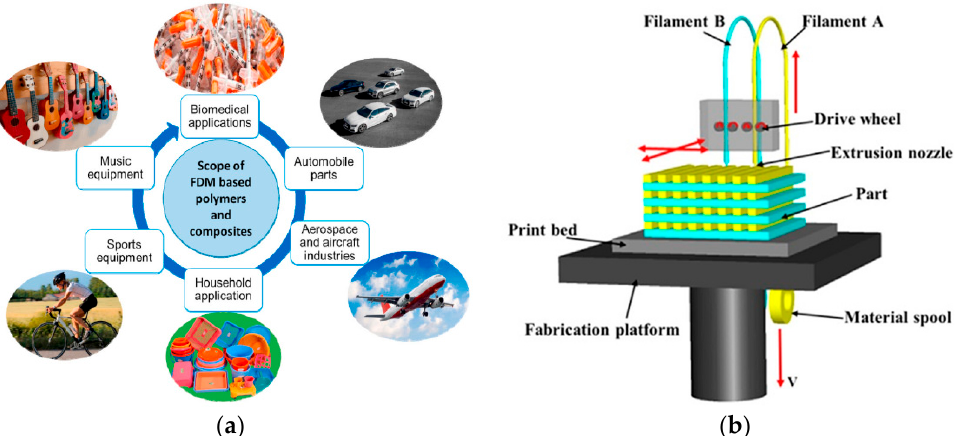
Figure 3. ( a ) Applications of FDM-based polymers and PMCs [12], and ( b ) schematic representation of a typical FDM setup [14].